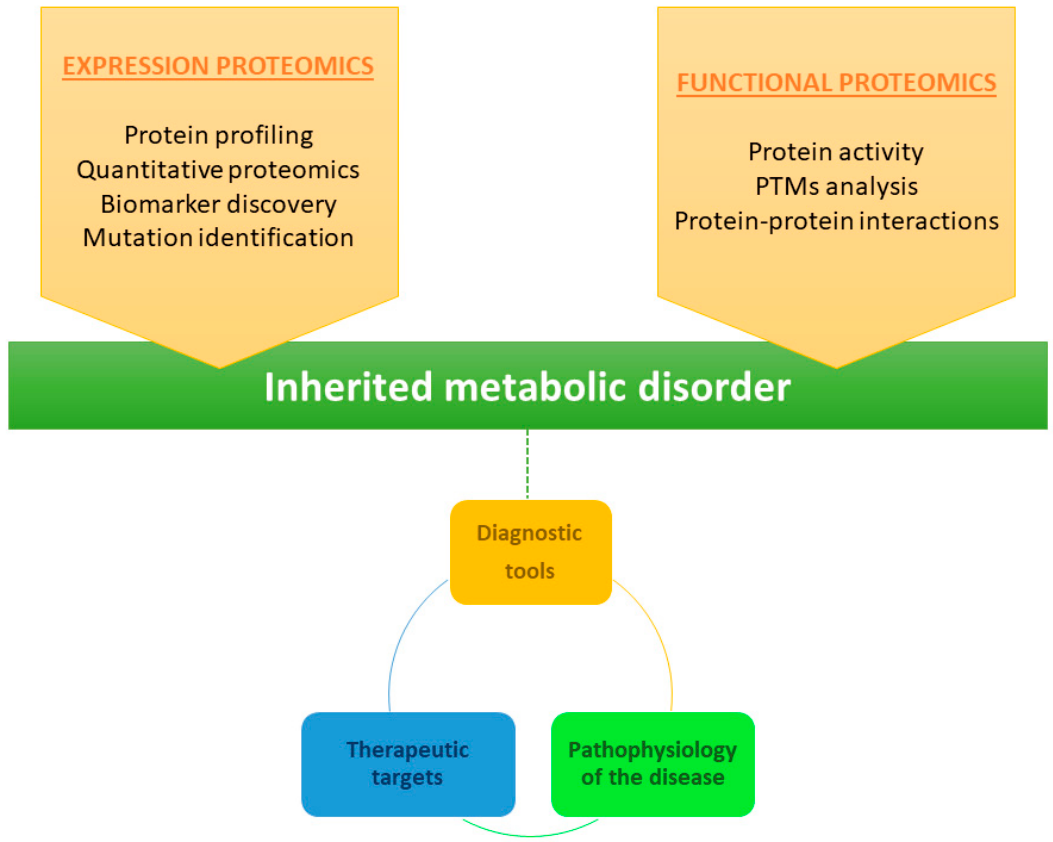
Figure 5. Proteomics methods used for the characterization of inherited metabolic disorders. A combination of expression proteomics (quantitative analysis of protein expression across different samples) and functional proteomics (analysis of the properties of molecular networks in a living cell) can be very useful in the search for diagnostic biomarkers and therapeutic targets in IMDs. Moreo- ver, the information acquired using these two approaches can help to better understand the patho- physiology of the disease.